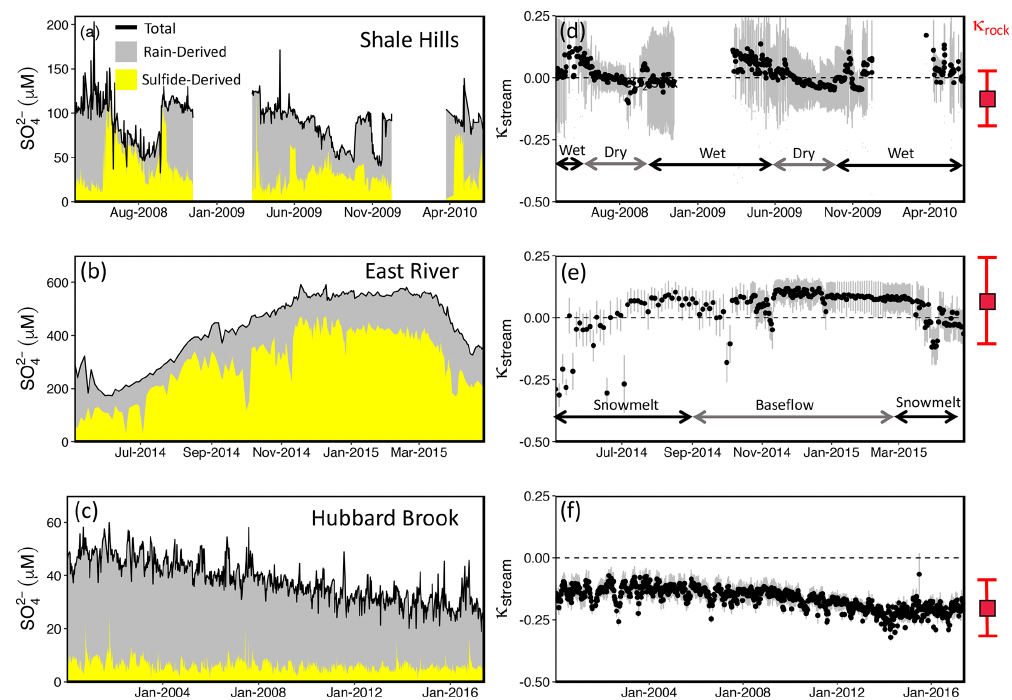
Figure 5. Concentration of total sulfate (black line), rain-derived sulfate (NMF-calculated; gray), and sulfide-derived sulfate (NMF- calculated; yellow) in stream water plotted versus time at Shale Hills (a) , East River (b) , and Hubbard Brook (W-3 sub-catchment) (c) . Shale Hills and East River temporally switch between being a source and sink of CO 2 , while Hubbard Brook is always a sink over the timescales studied, as shown by the CO 2 sequestration coefficient ( κ stream ) for Shale Hills (d) , East River (e) , and Hubbard Brook (f) . Gray error bars in (d) , (e) , and (f) represent 1 SD from the calculated κ stream for that sample. The range (mean + 1SD) indicated in red to the right of (d) , (e) , and (f) represents κ rock , the time-integrated CO 2 sequestration coefficient calculated from the rock chemistry (see text). Here, κ stream > 0 or < 0 indicates stream is a source or sink of CO 2 , respectively, when considering weathering reactions over 10 5 - to 10 6 -year timescales (see Fig. 1). The long record at Hubbard Brook shows that κ stream is approaching κ rock as the watershed recovers from acid rain. Gaps in the time series for Shale Hills occur when the autosampler tubing or stream